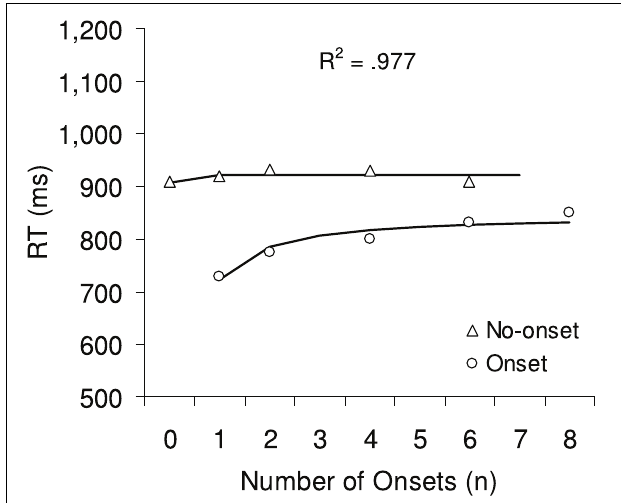
a multiple regression analysis, predicting RT based on the 1-tag model, which provided the best fit.